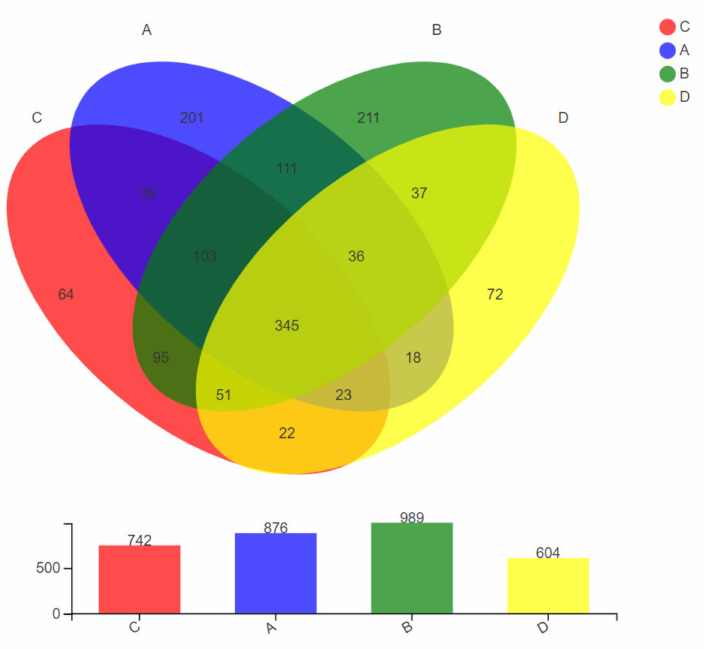
Figure 3. Venn of OTUs in each group.